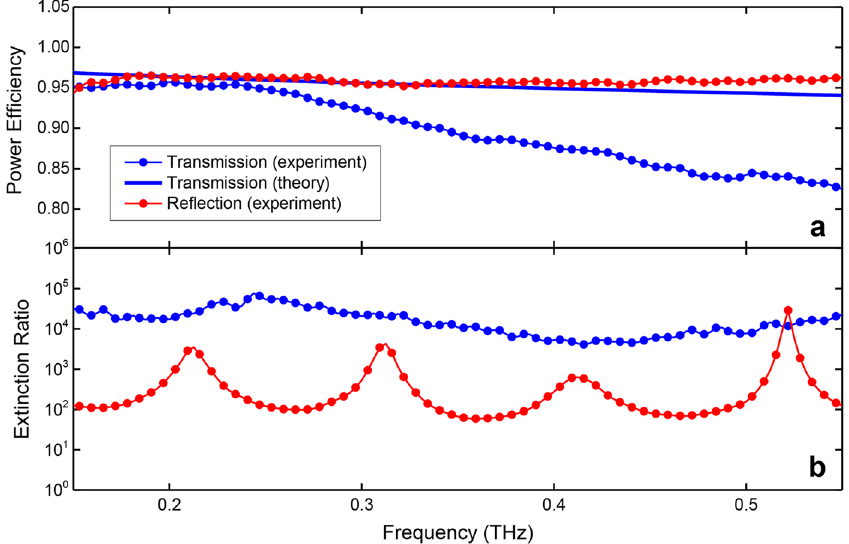
Figure 4. Power efficiency and extinction ratio. ( a ) Power efficiency for the transmission (blue dots) and reflection (red dots) arms, within the operational bandwidth. The blue solid curve gives the theoretical efficiency for the transmission arm taking into account only the ohmic loss. ( b ) Cross-polarization extinction ratio for the transmission (blue dots) and reflection (red dots) arms, within the operational